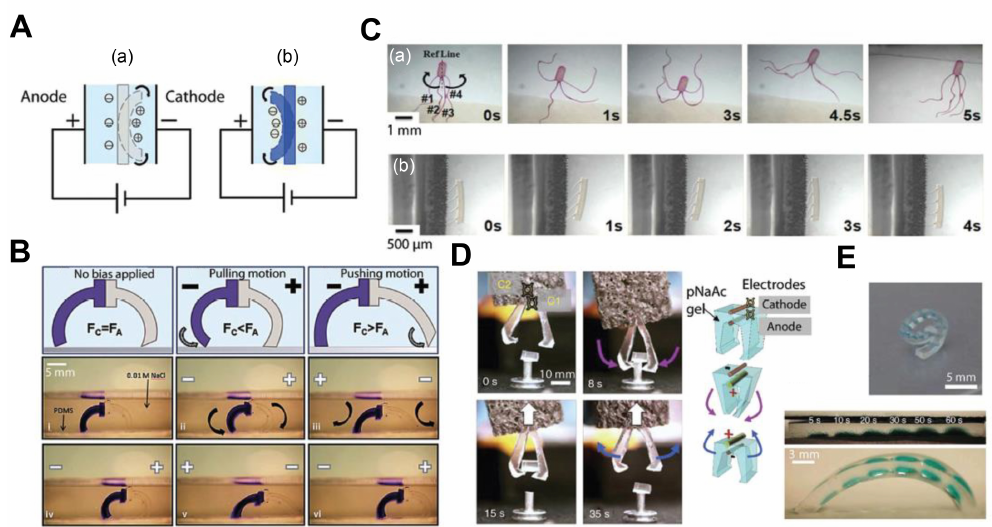
Figure 4. Ionic-hydrogel-based actuators. ( A ) Basic diagram of mechanism with ( a ) anionic and ( b ) cationic gels in the same solutions; each could achieve opposite bending directions under the same applied field. ( B ) Walker achieved unidirectional motion using both anionic and cationic gels. A field of 5 V/cm was applied; electrode field directions are shown in the images. ( C ) Locomotion of an anionic gel ( a ) octopus and ( b ) walker under electric fields in solution; the applied voltage signals were alternating (+7 V/ − 15 V) and ± 15 V, respectively. ( D , E ) Patterning of hydrogel using ionoprinting for directional embedding of ions. ( D ) A gel gripper was able to grasp and release